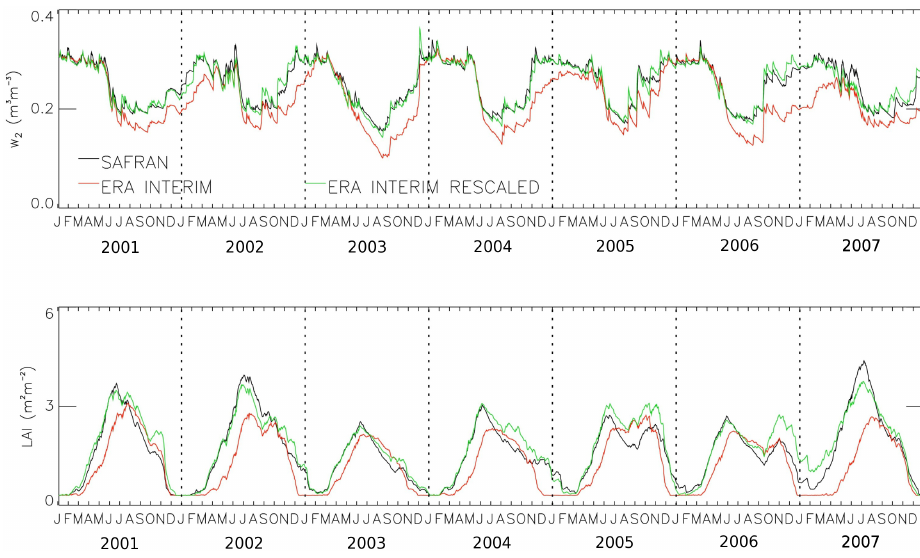
Fig. 11. Impact of the use of different atmospheric forcings (SAFRAN, ERA-I, ERA-I-R) on the ISBA-A-gs simulations of (top) root zone soil moisture and (bottom) leaf area index of the SMOSREX grassland in southwestern France